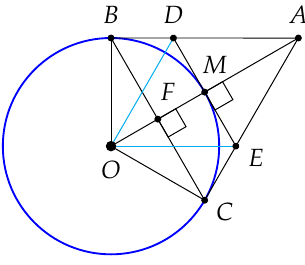
Figure 1. The intersection of adjacent edges of a circumscribed polygon and its